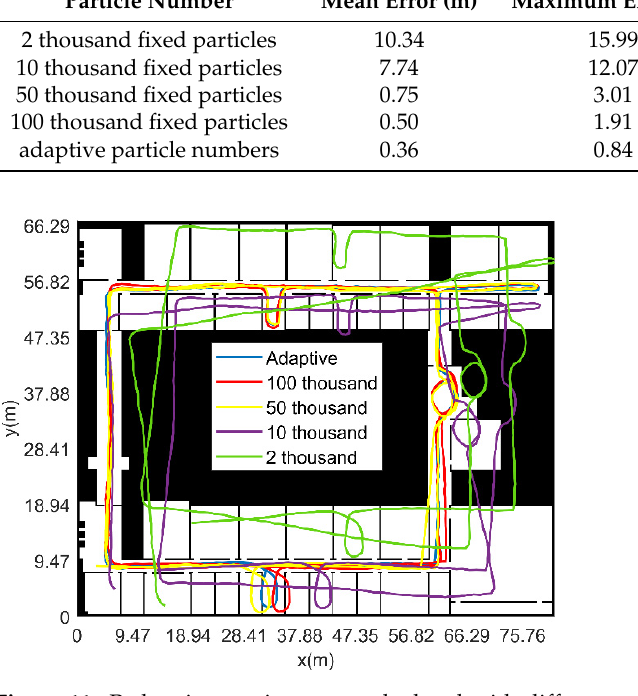
Figure 11. Pedestrian motion trace calculated with different particle numbers under simulation conditions.